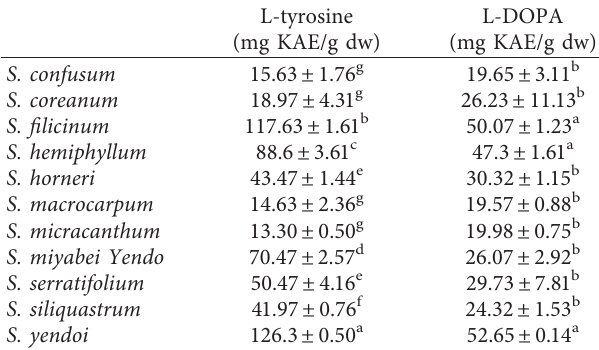
Table 3: Tyrosinase inhibition activity of Sargassums